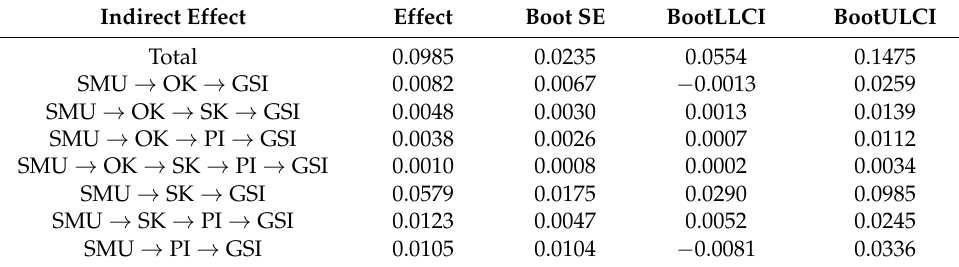
Table 4. Indirect effects and the bootstrapping confidential